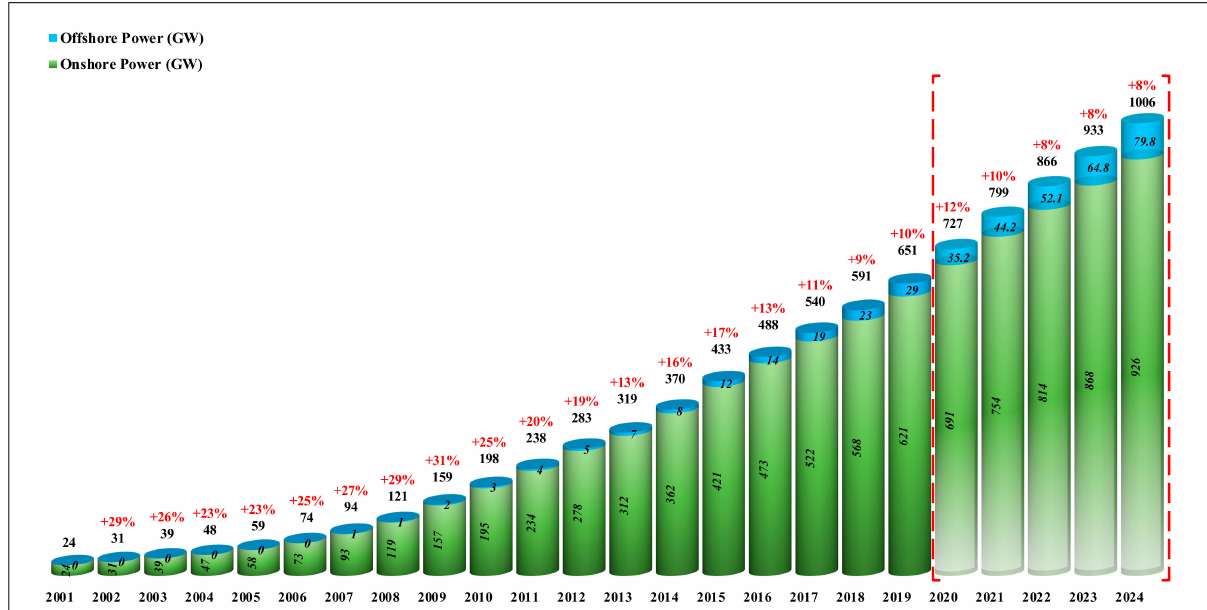
Figure 1. ( a ). Distribution of global renewable energy (2019). ( b ). Size comparison of the largest wind turbine (SG 14–222 DD) with Boeing Airbus A380 and the Eiffel tower.